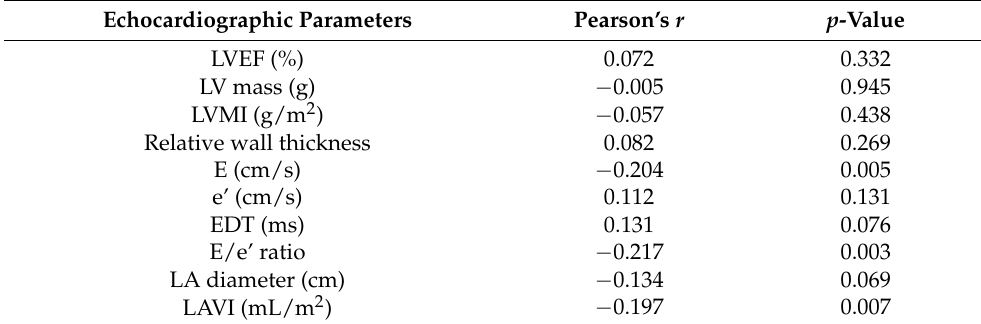
Table 2. Correlation between serum zinc level and echocardiographic parameters in study